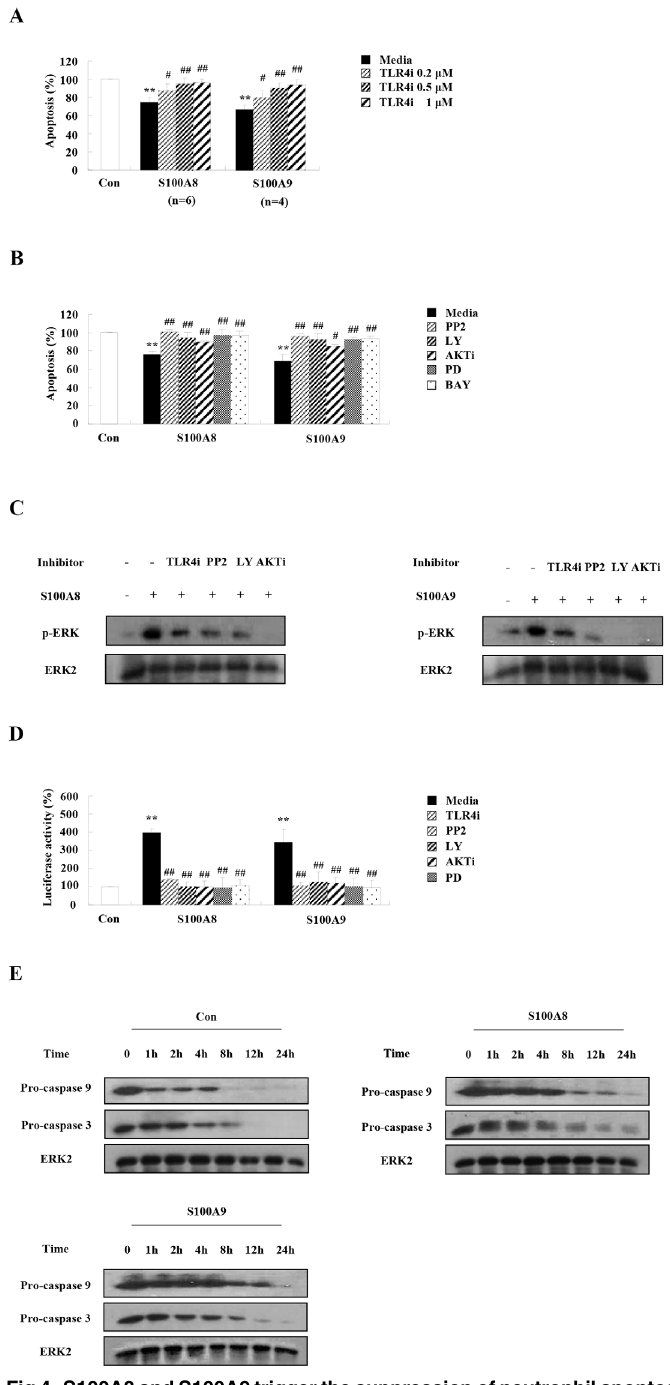
Fig 4. S100A8 and S100A9 trigger the suppression of neutrophil apoptosis through activation of TLR4, Lyn, PI3K, Akt, ERK and NF- κ B, and via suppression of the caspase9/3 pathway. (A-B) Normal neutrophils (4 < n < 6) were pre-treated for 1 h with and without TLR4i in the indicated concentration (A) or 10 μ M PP2, 10 μ M Ly294002 (LY), 10 μ M AKTi, 10 μ M PD98059 (PD) and 10 μ M BAY-11-7085 (BAY) (B), after which the cells were incubated for 24 h in the absence and presence of S100A8 and S100A9 (10 μ g/ml). Apoptosis was analyzed by measuring the binding of annexin V-FITC and PI Data are expressed as the means ± SD and are presented relative to the control, which was set at 100%. ** p < 0.01 indicates a significant difference between the control and DP-treated groups, and # p < 0.05 and ## p < 0.01 represent